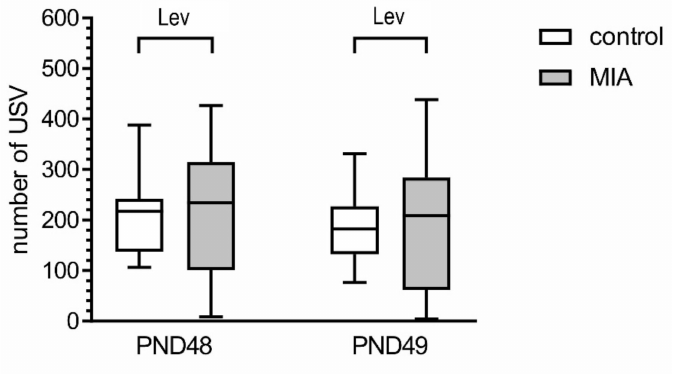
Figure 3. MIA induces play behavior alterations in adolescent o ff